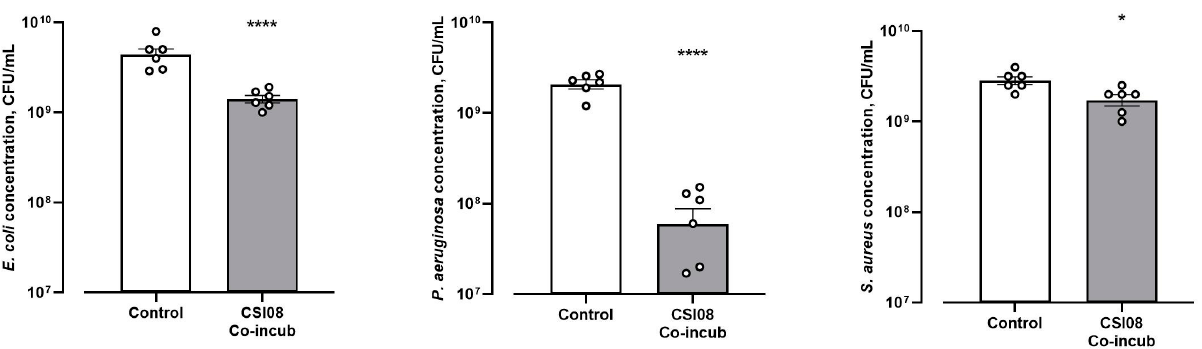
Figure 3. Antimicrobial activity B. clausii CSI08 in liquid culture. Values represent average concen- tration ± SEM of two independent experiments with three technical replicates (n = 6). * p < 0.05, **** p < 0.0001.